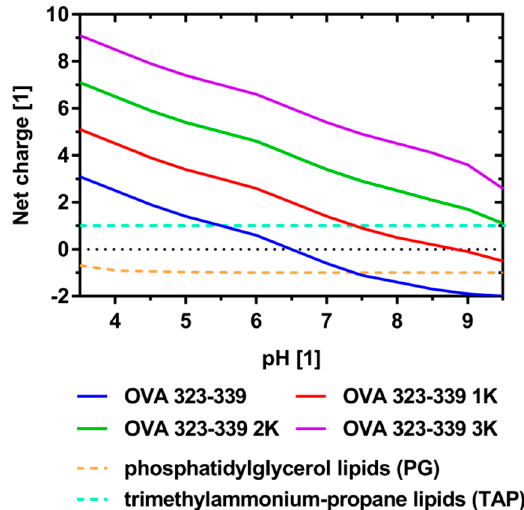
Figure 1. Net charge / pH profiles of the model peptides and study-relevant phospholipids. The net charge of the model peptides as a function of pH as calculated by PROTEIN CALCULATOR v3.4 is shown [37]. Data for the PG net charge / pH profile were adapted from [38]. TAP lipids such as DOTAP exhibit a pH-independent net charge of + 1 [39].